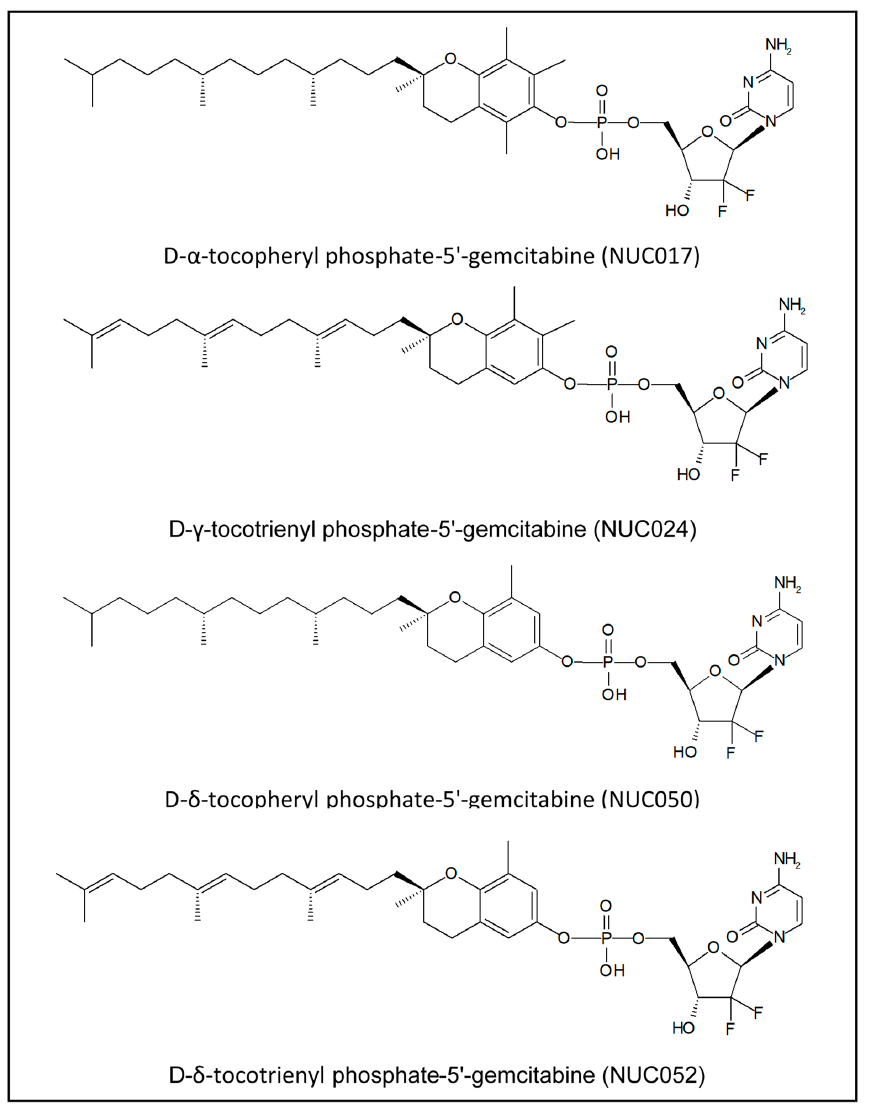
Figure 1. Isoforms of VE conjugated with gemcitabine phosphate.